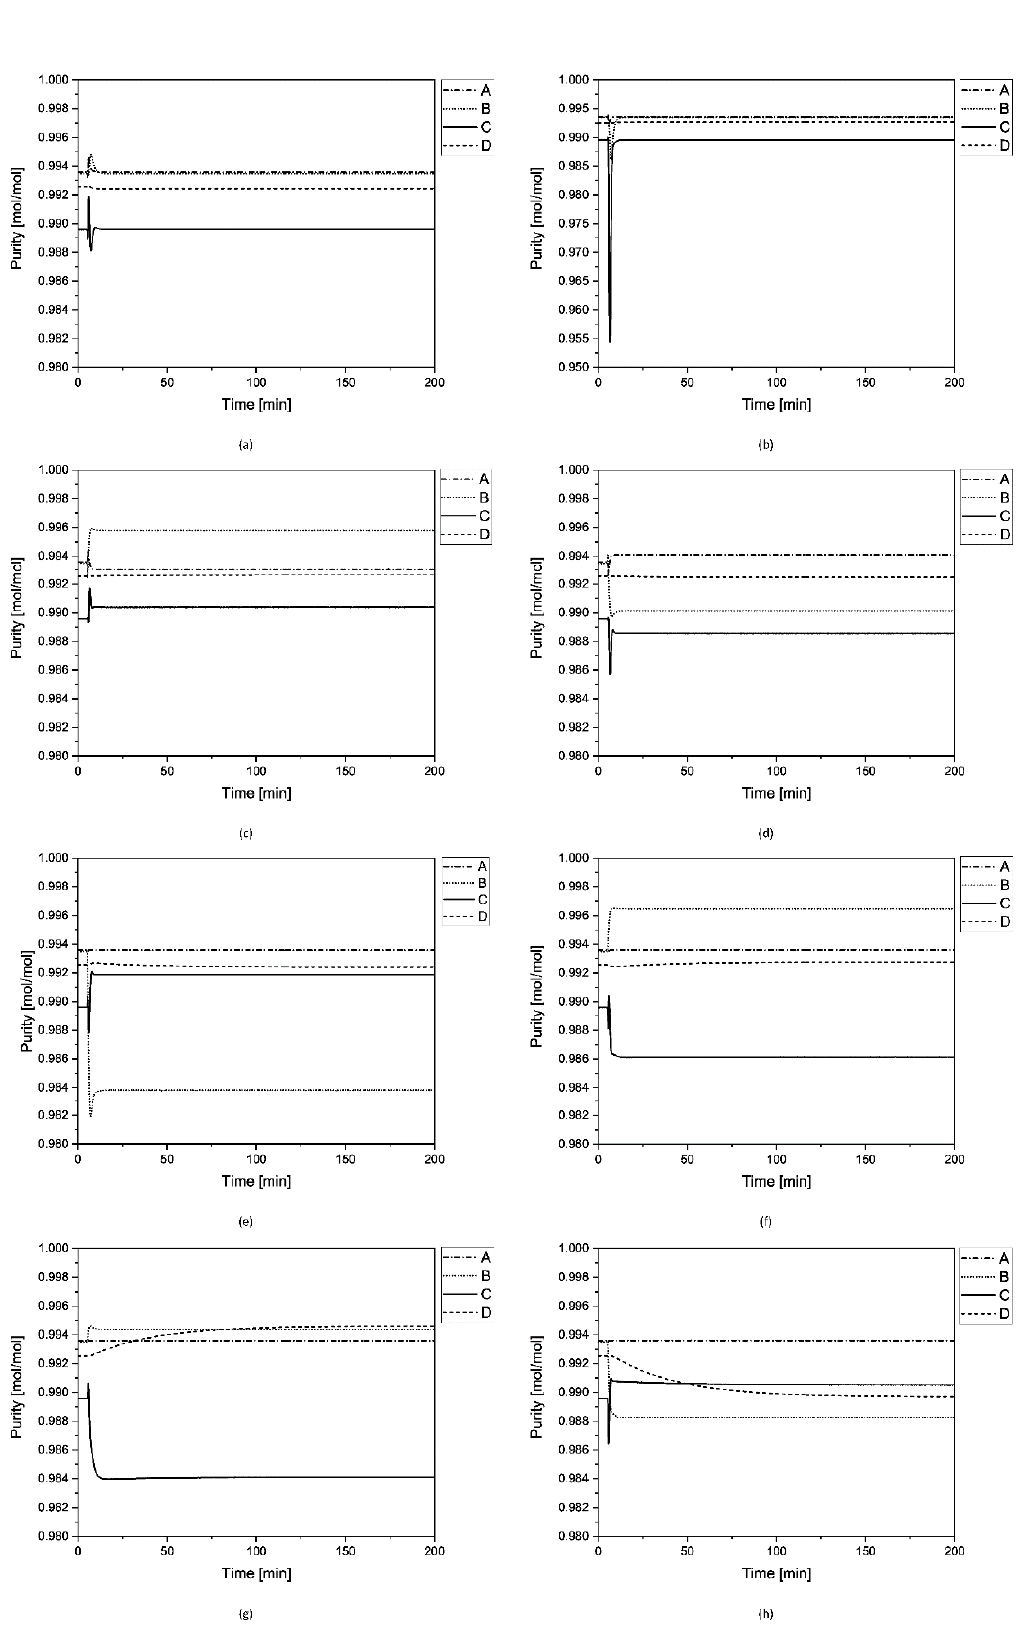
Figure 11. Simulated dynamic results on product qualities for mixture 3 for different disturbances: ( a ) scenario 1, ( b ) scenario 2, ( c ) scenario 3, ( d ) scenario 4, ( e ) scenario 5, ( f ) scenario 6, ( g ) scenario 7, and ( h ) scenario 8.